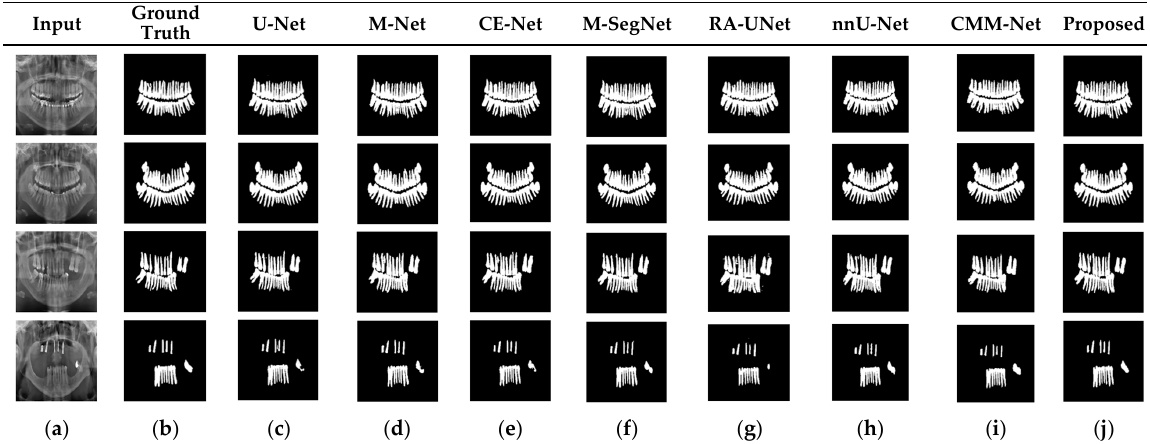
Figure 5. Qualitative comparison of the proposed method and existing methods for the UFBA-UESC dental dataset. From left to right: ( a ) original input image; ( b ) ground-truth segmentation map; ( c – j ) segmentation results obtained using U-Net, M-Net, CE-Net, M-SegNet, RA-UNet, nnU-Net, CMM-Net, and the proposed method, respectively.